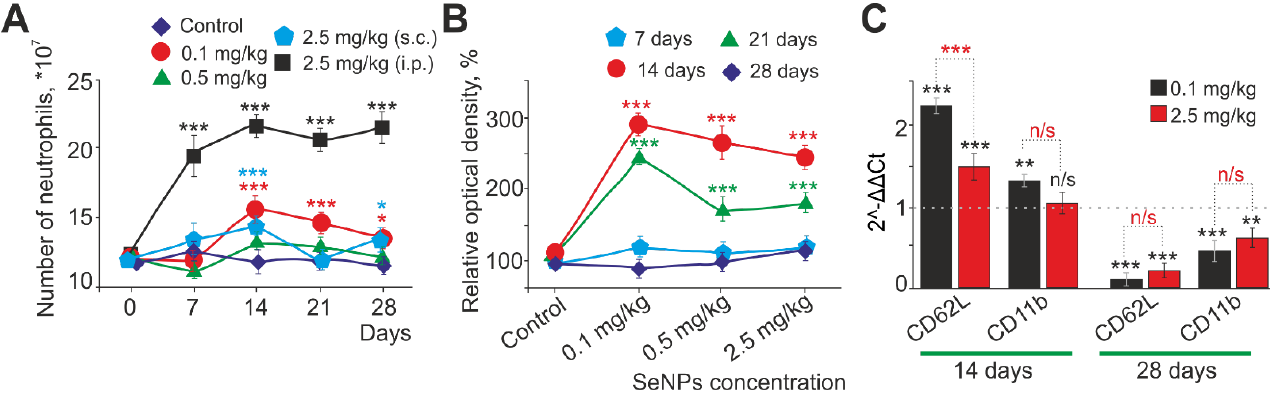
Figure 1. Effect of injection of various concentrations of SeNPs into mice on the neutrophil number and adhesion. ( A )—Dose- and time-dependent increase in the number of neutrophils isolated from mice peritoneal cavities after zymosan injection. The curves show the counts of neutrophil migration induced by zymosan (5 mg/mL) at 5 h after the daily intraperitoneal injection of SeNPs or saline (control) on days 7, 14, 21, and 28. Abbreviations: 2.5 mg/kg (s.c.)—subcutaneous injections of SeNPs and 2.5 mg/kg (i.p.) intraperitoneal injections of SeNPs. The data are the mean values ± SEM of seven mice. * p < 0.01 compared with respective control group. Peritoneal evoked neutrophils of male mice of outbreed strain BALB/c were used in the experiments. Neutrophils comprised nearly 98% of the total number of cells, as determined by acridine orange staining. ( B )—Dose- and time-dependent modification of neutrophil adhesion on days 7, 14, 21, and 28 after daily injection of SeNPs or saline (control). Concentration-dependent effects of SeNPs (0.1 mg Se/kg, 0.5 mg Se/kg, 2.5 mg Se/kg) on mouse neutrophil adhesion: с urves shown are blue—on day 7, red—on day 14, green—on day 21, and dark blue—on day 28 of administration of SeNPs, respectively. Adhesion was determined by spectrophotometric analysis at 492 nm and then OD492 in the neutrophils from experimental groups with administration of SeNPs normalized to the same parameter measured in control group. Data presented are the mean ± SEM ( n = 7). Statistical analyses of experimental groups vs. control were performed with paired t -test. Significance between group means: * p < 0.05, ** p < 0.01, and *** p < 0.001. Values not marked with an asterisk are invalid. ( C )—Effect of SeNP injection in vivo on expression of neutrophil adhesion molecules CD11b and CD62L. Relative mRNA expression of genes encoding of CD11b and CD62L in neutrophils on days 14 and 28 after daily injection of 0.1 mg Se/kg (black bars) and 2.5 mg Se/kg (red bars) SeNPs. Dashed line—level of gene expression in controls (mice with administration of saline). GAPDH was used as housekeeping gene. Data are shown as mean ± SEM of five independent experiments. Statistical analysis of experimental groups versus control was performed with paired t -test and is marked with black asterisks. Significance between experimental groups is marked with red asterisks: *** p < 0.001 and ** p < 0.01; n/s—no